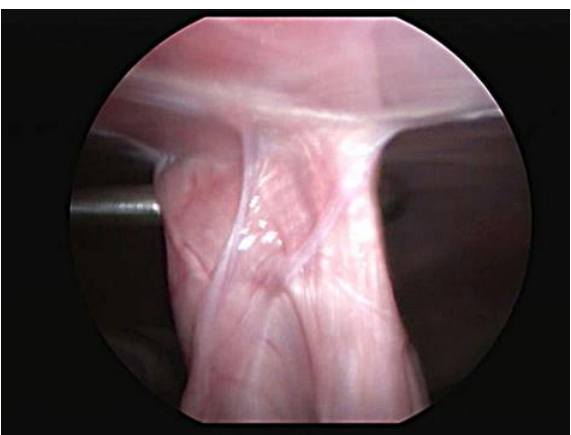
Figure 3. Laparoscopic view of the intact gastropexy 6 months